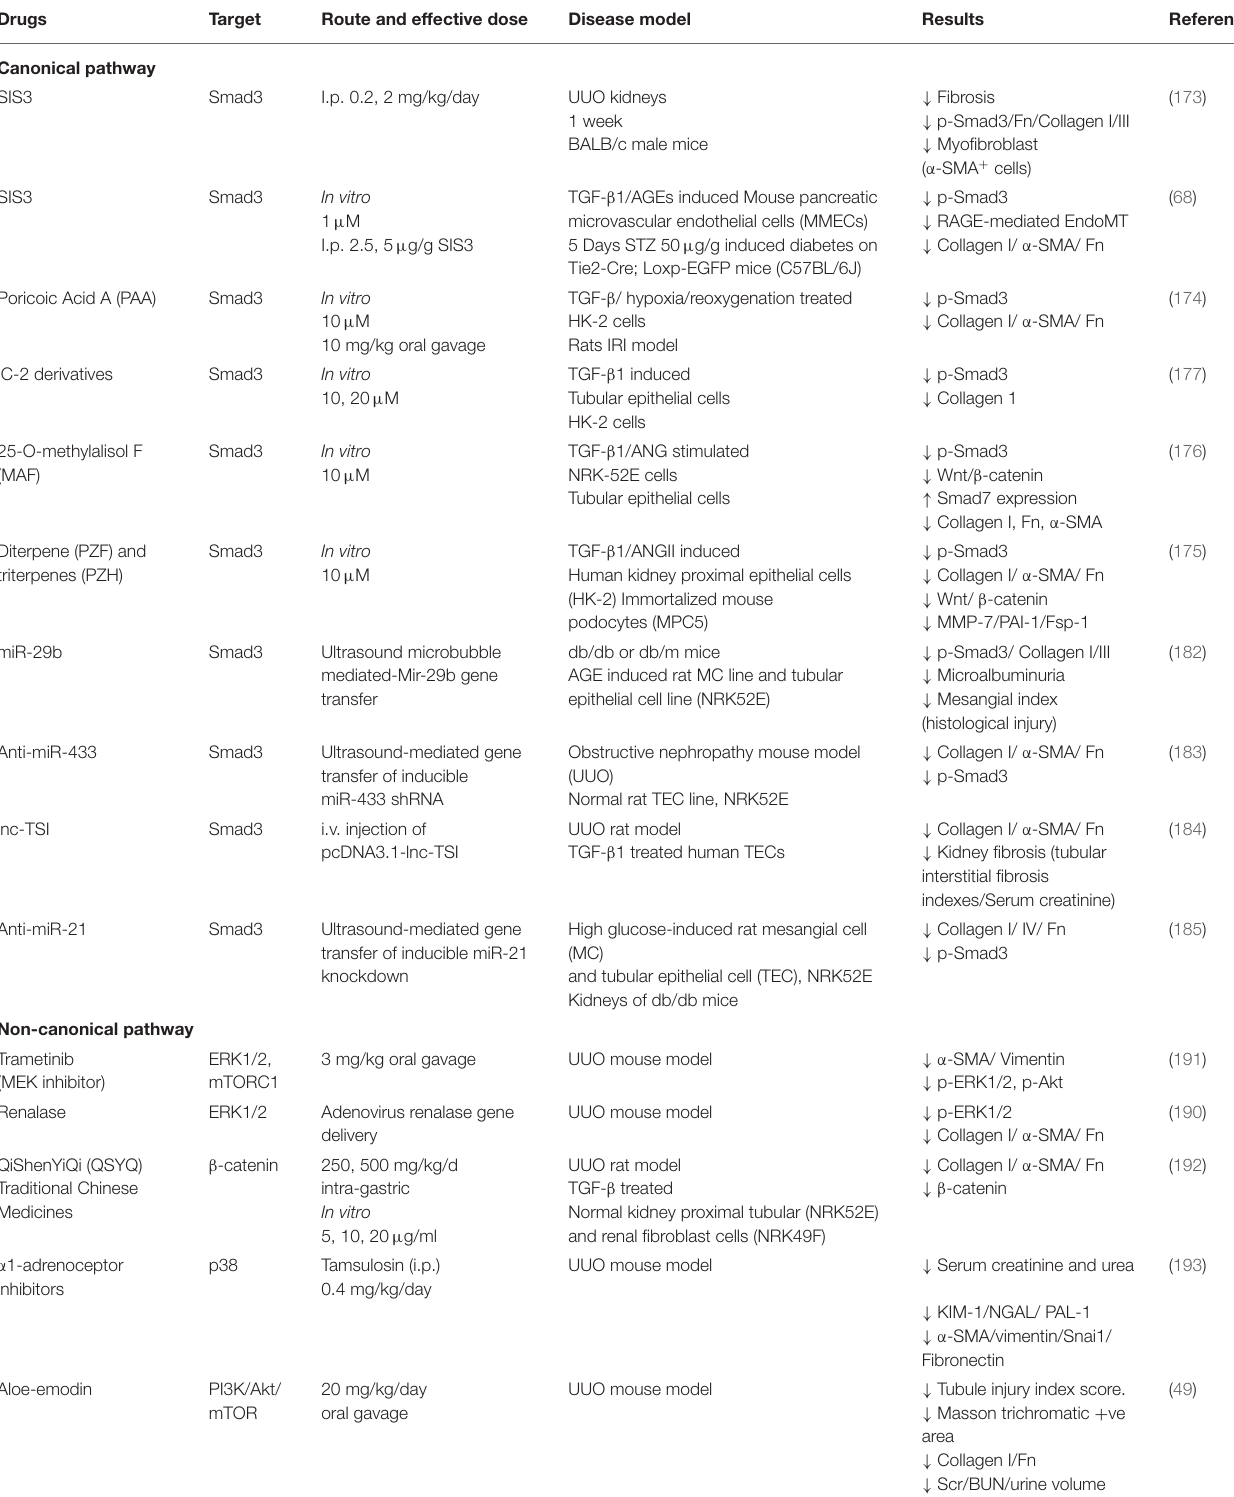
TABLE 1 | Pre-clinical studies for the treatment of CKD by specifically targeting the downstream of TGF- β 1. Drugs